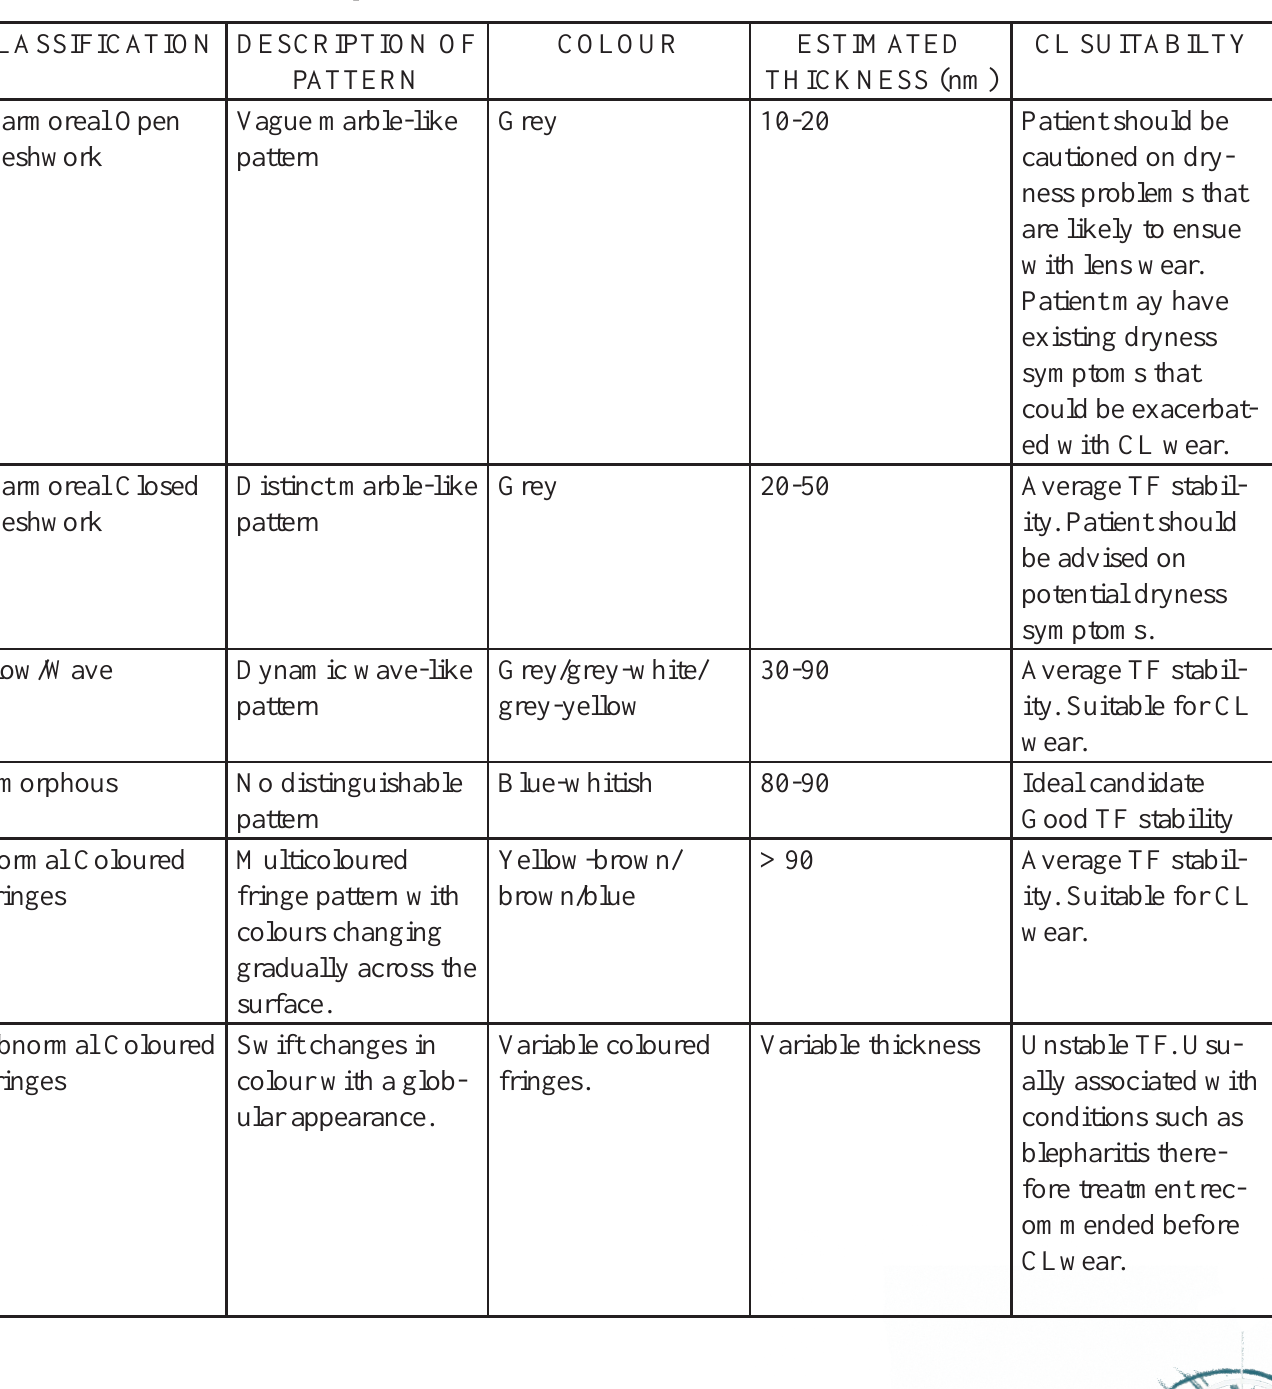
Table 1: Classification of interference patterns 12, 14, 19-21, 32, 33